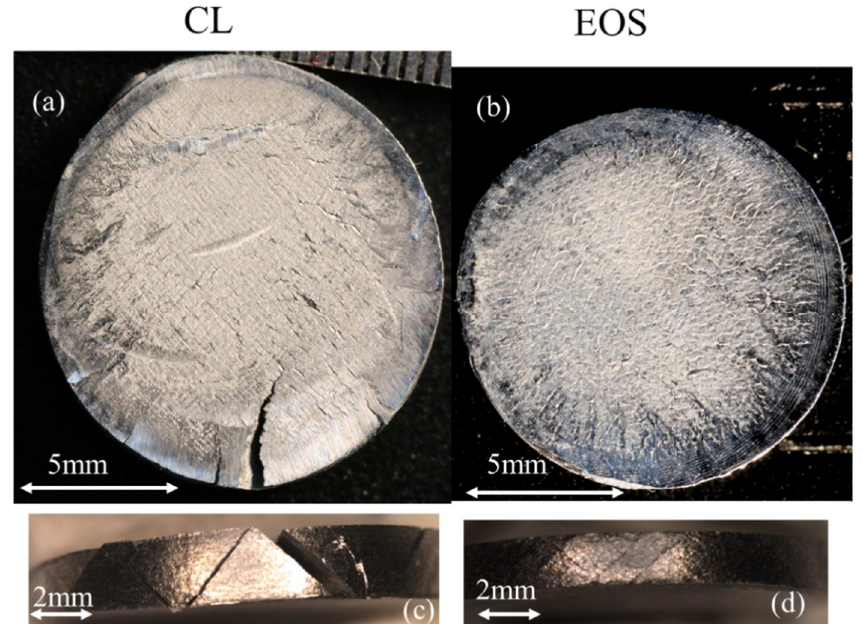
Figure 13. Z-oriented samples after SHPB tests at strain rate of 5800 to 6700 s − 1 , with plane view of samples for ( a ) CL and ( b ) EOS, and sample circumferences for ( c ) CL and ( d ) EOS.